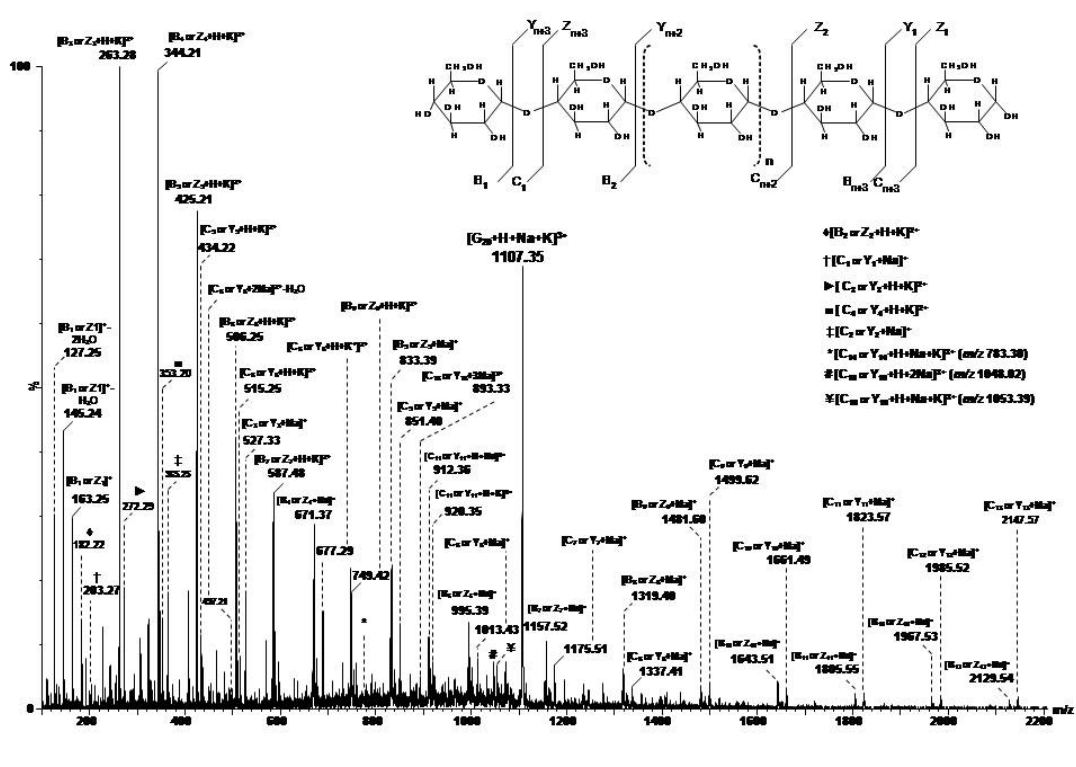
+H+Na+K] 3+ in Dex 4. Cone voltage 50 V. Capillary 20